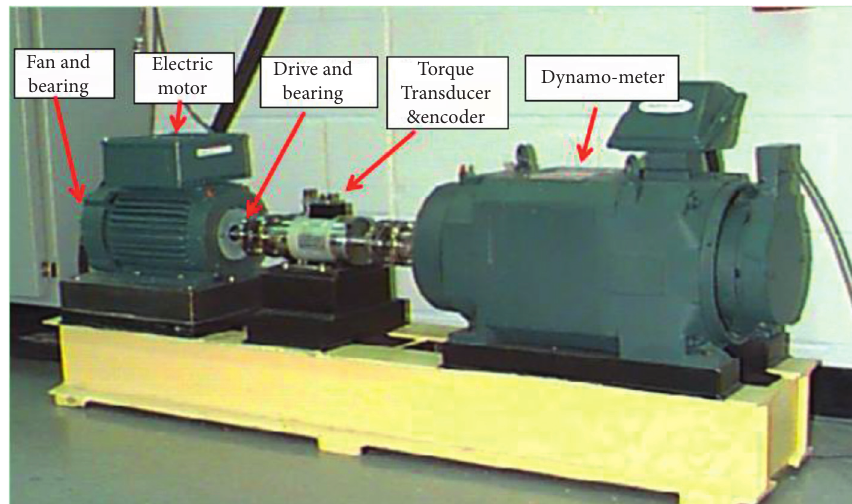
Figure 5: Rolling bearing test bench.